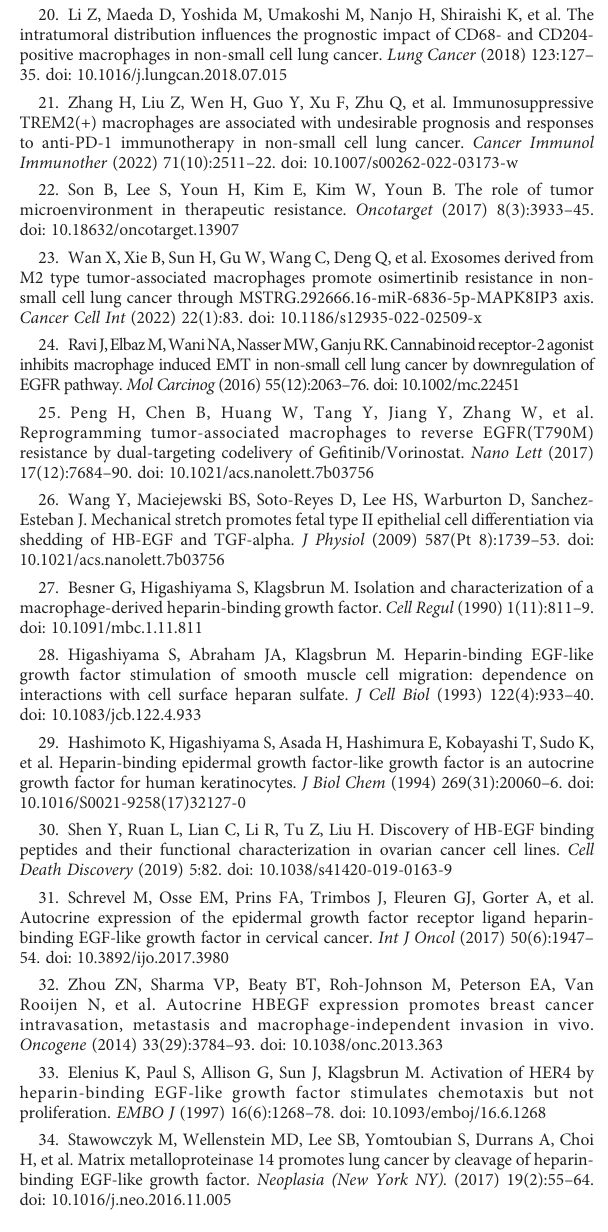
SUPPLEMENTARY FIGURE 3 The dot-plot of selected marker for 8 cell types using single-cell RNA sequencing data GSE131907. Epithelial cells markers: EPICAM, KTR18/19, CDH1; Fibroblast cells markers: DCN, THY1, COL1A1/2; Endothelial markers: PECAM1, CLDN5, FLT1, RAMP2, T cell ’ s markers: CD3D/E/G, TRAC; Natural killer cells markers: NKG7, GNLY, NCAM1, KLRD1; B cells markers: CD79A, IGHM, IGHG3, IGHA2; Myeloid cells markers: LYZ, MARCO, CD68, FCGR3A; Mast cells markers: KIT, MS4A2,